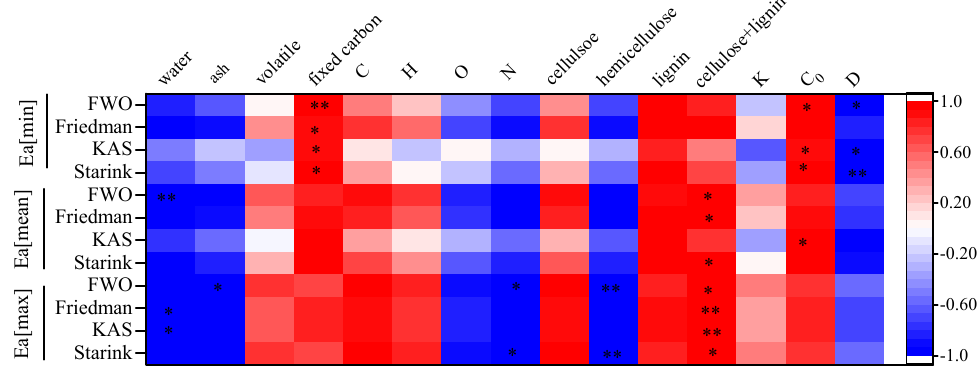
Figure 4. Correlation coefficient matrix of biomass intrinsic physicochemical properties and Ea[min], Ea[mean], and Ea[max]; * means p < 0.05, ** means p <